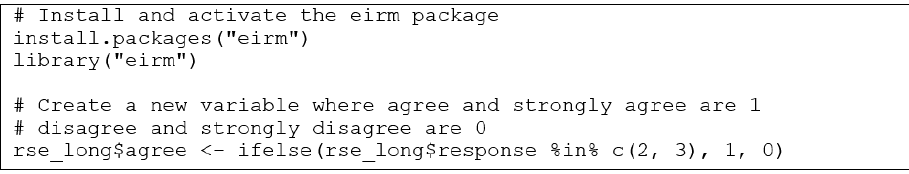
Figure 3. Install and activate the eirm package and create a new response variable. To estimate the Rasch model for the RSE dataset, we will use the eirm() function, which is the primary function to estimate explanatory IRT models in the eirm